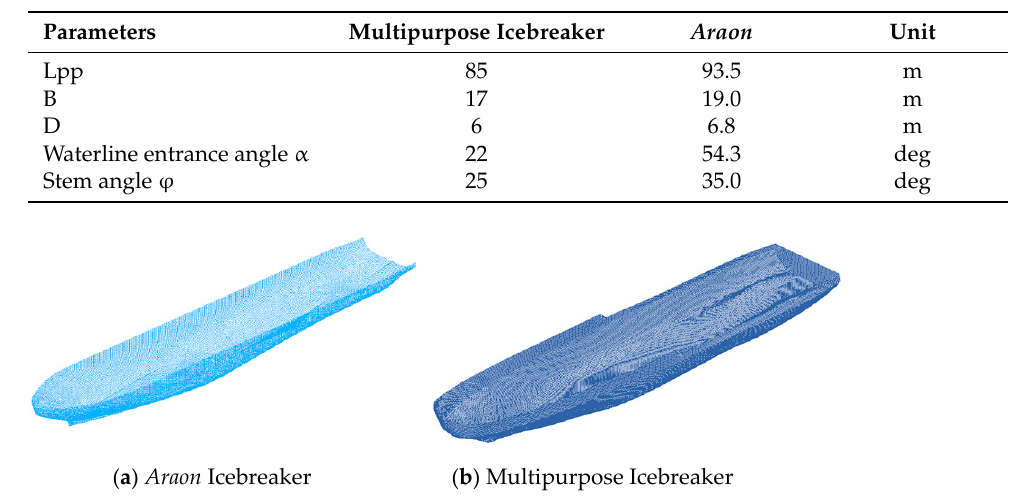
Table 3. Parameters of Araon and multipurpose icebreaker.